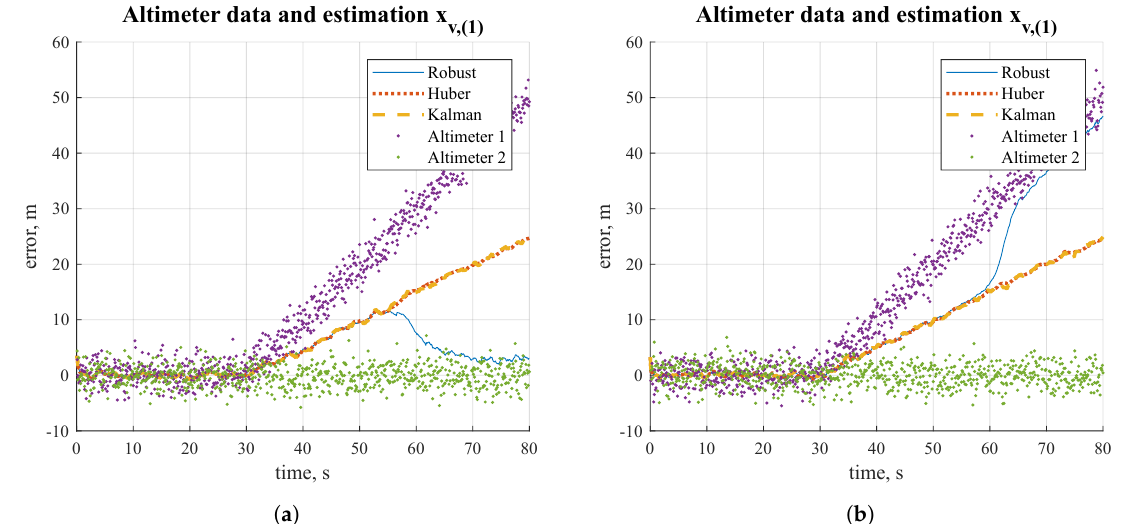
Figure 9. Modelling of a slow divergence of altimeters measurements. In sample ( a ) robust filter tracks second altimeter measurements. In sample ( b ) robust filter tracks first altimeter measurements. The choice is made